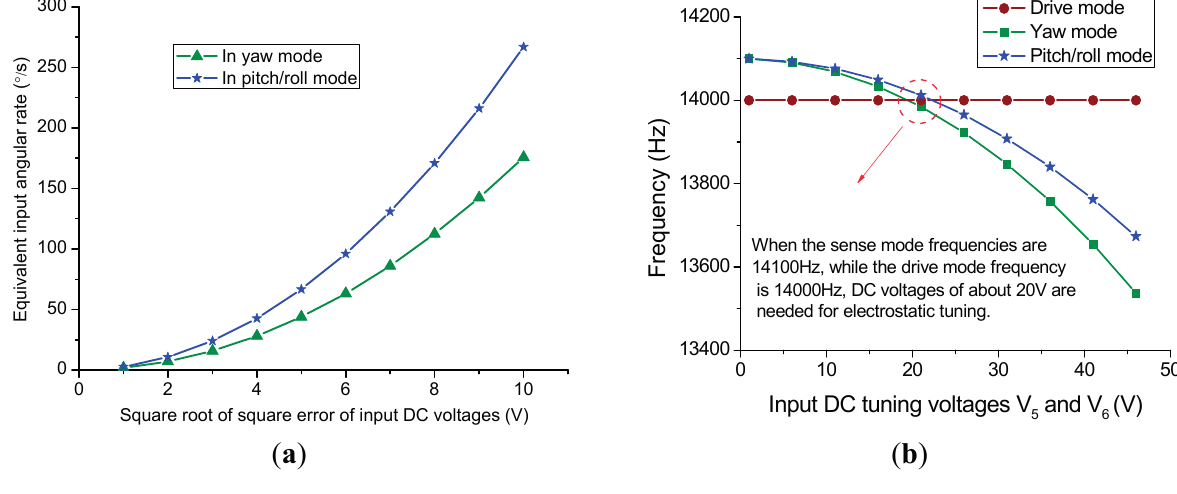
Figure 11. Simulation results of ( a ) quadrature error correction and ( b ) frequency